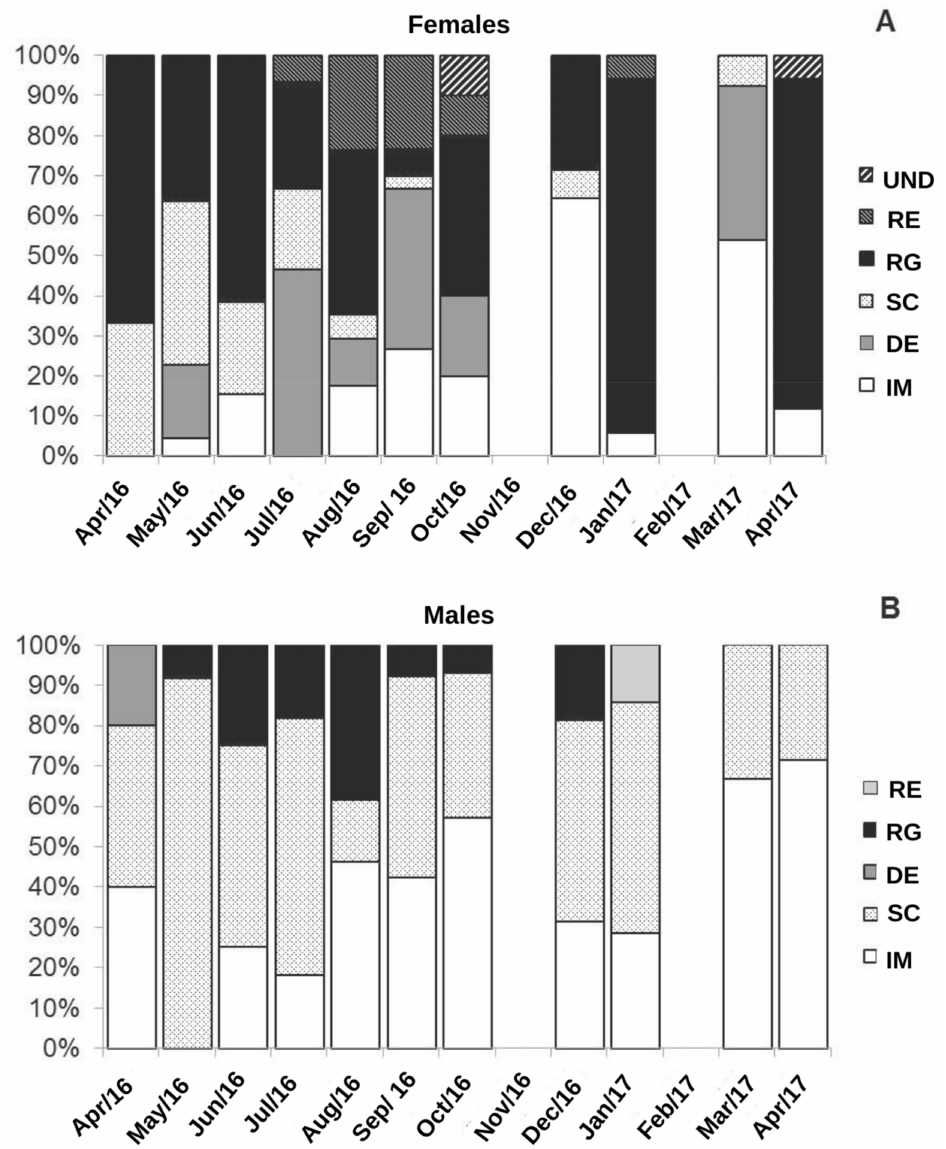
Figure 4. Relative percentage of gonadal maturation stages of females and males of Genyatremus luteus collected from April/16 to April/17 at Ajuruteua peninsula, Bragança, PA, Brazil. ( A )—females, ( B )—males, IM: immature, DE: development, SC: spawning-capable, RG: regressing, RE: regeneration, UND: